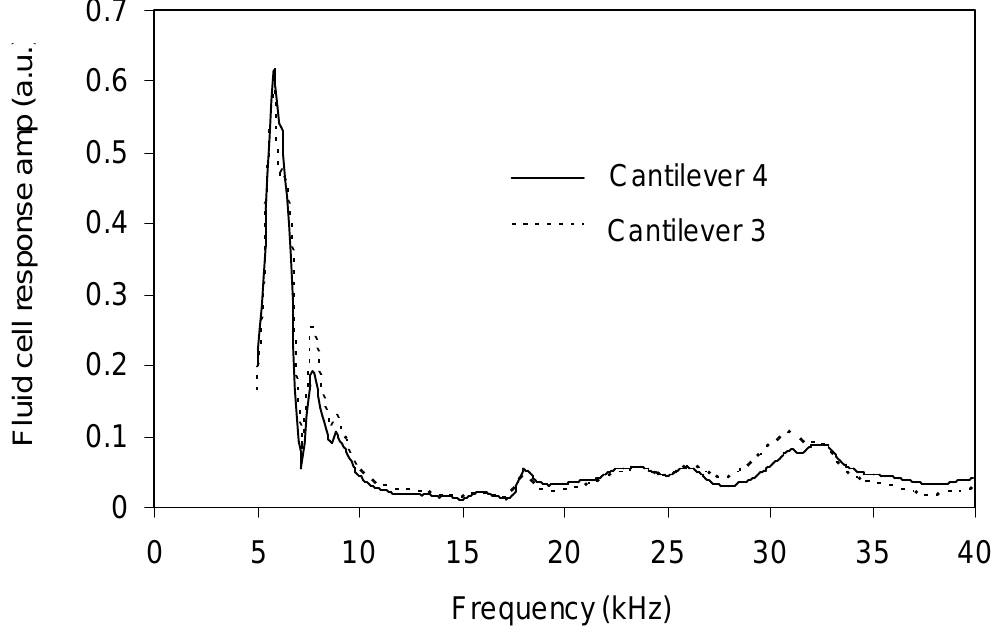
Figure 9. Fluid cell frequency responses obtained from the excitation of two different cantilevers in 75% glycerin-water solution. Cantilevers 3 and 4 have lengths of 397 and 197 m m